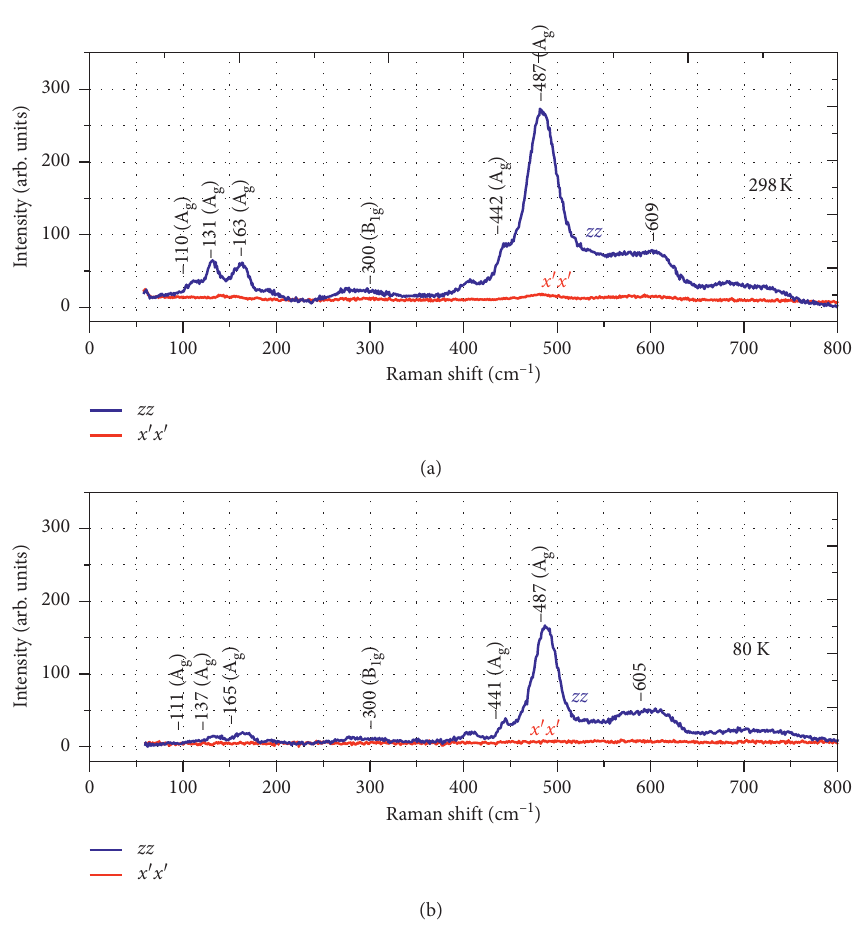
Figure 4: zz and x ′ x ′ polarization Raman spectra of (110)-oriented Ga doped PBCO thin